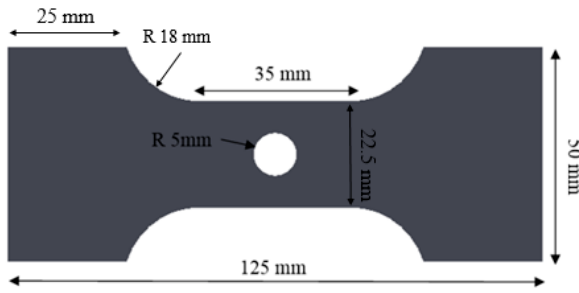
Figure 4. A specimen geometry of DP780 hole tension test.